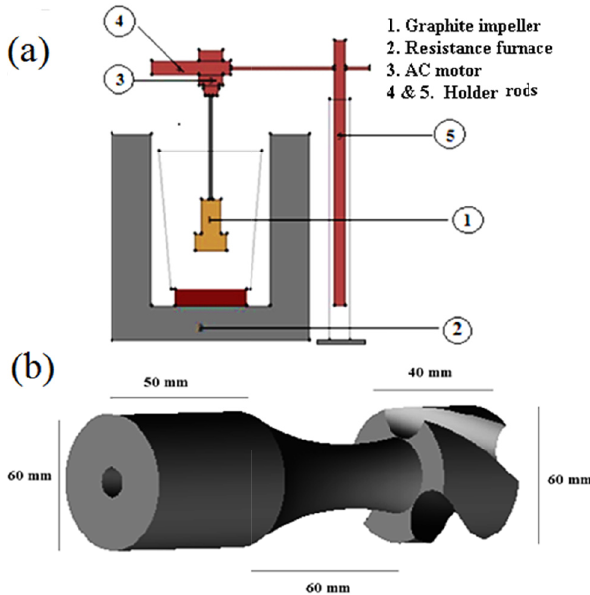
Fig. 2. (a) Schematic representation of the compocasting apparatus and (b) graphite impeller used in this study.